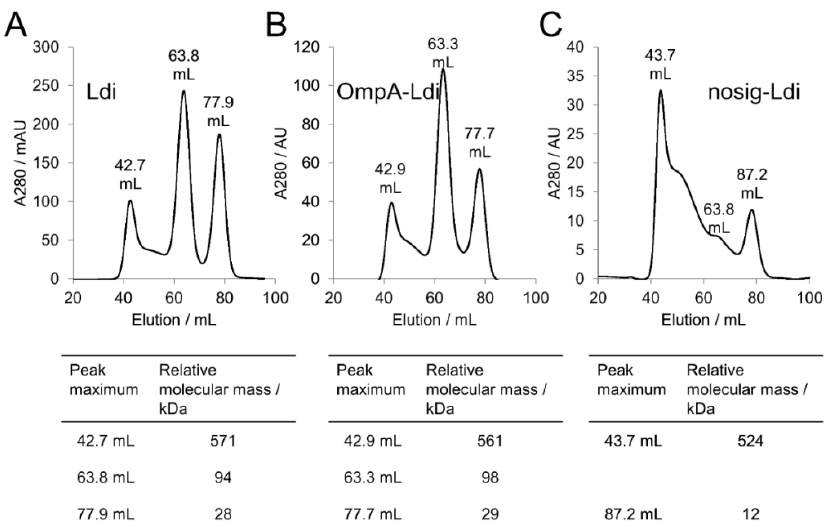
Figure 5. An N-terminal periplasmic signal sequence provokes formation of distinct Ldi oligomers in solution. Different oligomeric assemblies of His 10 -tag purified Ldi ( A ), OmpA-Ldi ( B ), and nosig-Ldi ( C ) in solution were separated by gel filtration. Relative molecular masses of major fractions were determined on basis of a calibration with standard proteins.